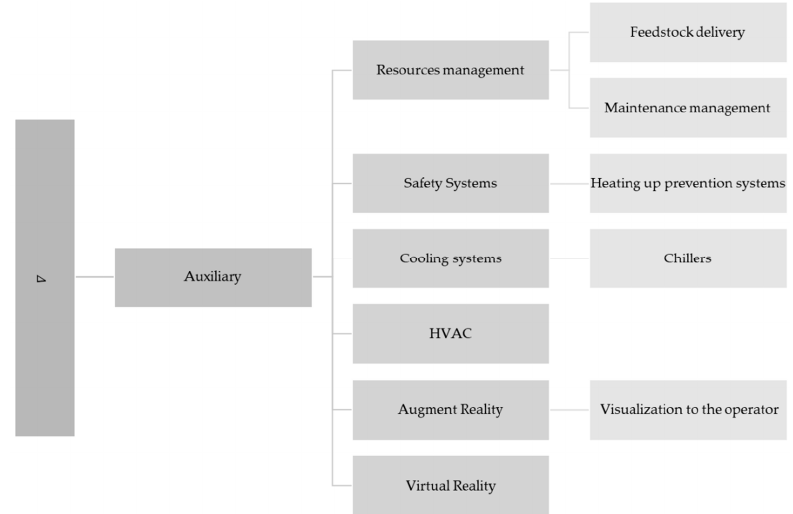
Figure A2. Technologies’ classification: Cell-related branch.